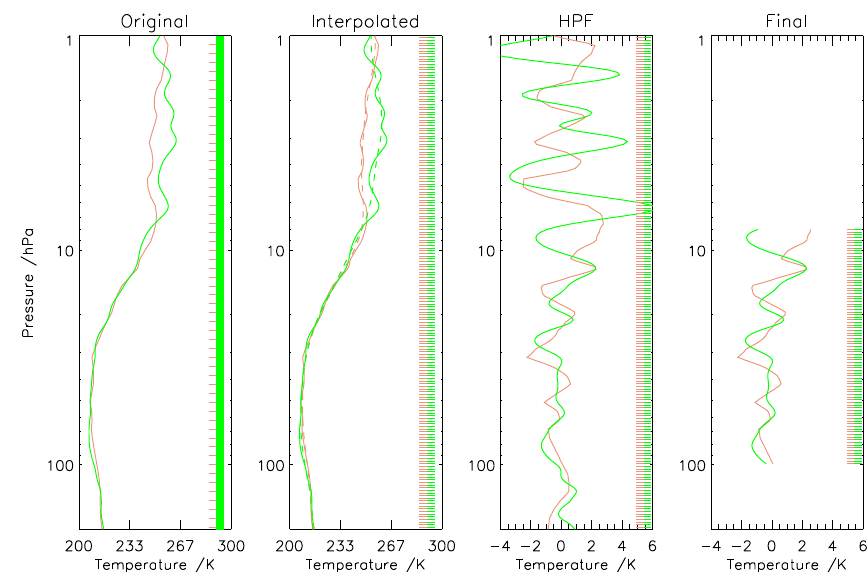
Fig. 2. Illustration of the data preparation applied for our correlation/standard deviation analyses, showing a comparison between a HIRDLS (orange) and COSMIC (green) profile. From left to right, the first panel shows the original profiles, the second the data interpolated onto the 200m scale with the half-bell-smoothed profiles overplotted with dashed lines, the third the perturbation profiles remaining after the half-bell smoothing, and the fourth the height region under investigation extracted. In each case, the coloured lines at the right indicate the height levels under consideration at that stage of the analysis, with orange indicating HIRDLS levels and green COSMIC levels. Note that, in this example, the COSMIC profile shown continues to an altitude above 1hPa, whilst in practice most do